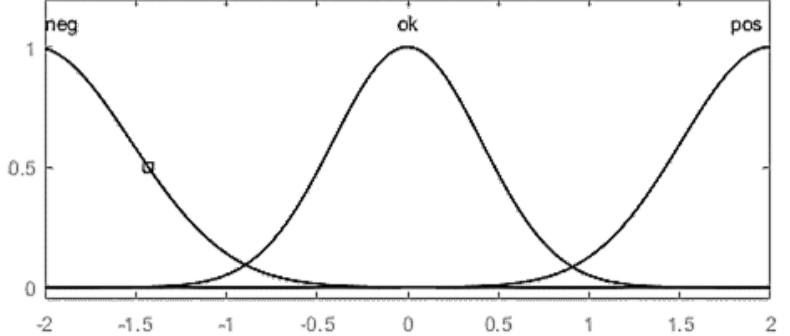
Figure 7. Membership functions for the input variable “error” e (t).